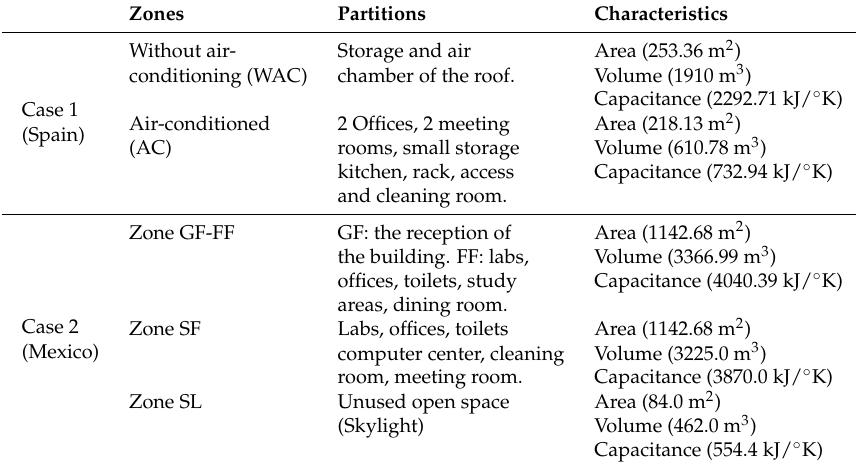
Table A2. Distribution of the cases of study.